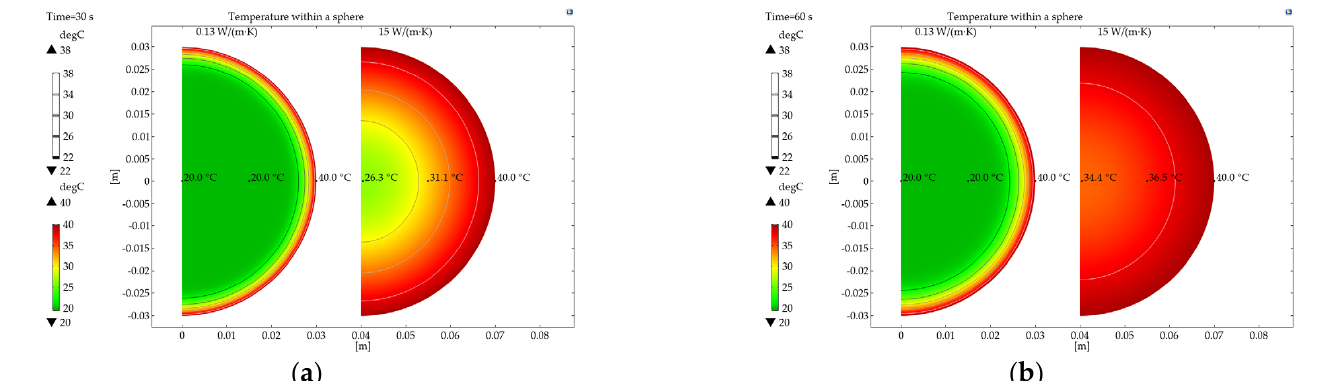
Figure 4. Simulated temperature evolution at three positions for ( a ) t = 30 s and ( b ) t = 60 s [12].